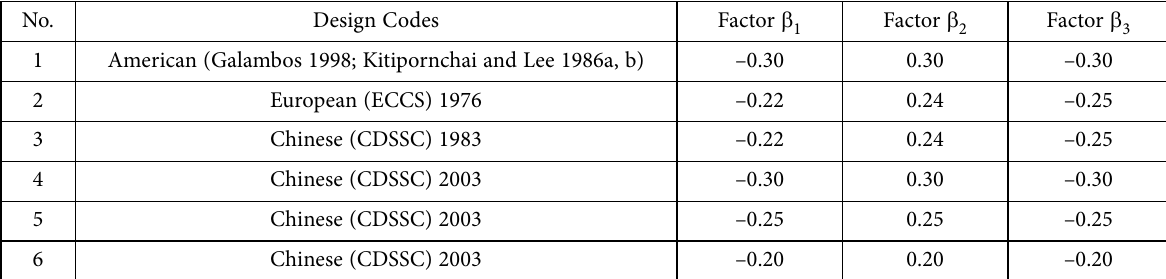
Table 5. Residual stress factors of equal angles adopted in American, European, and Chinese codes No.